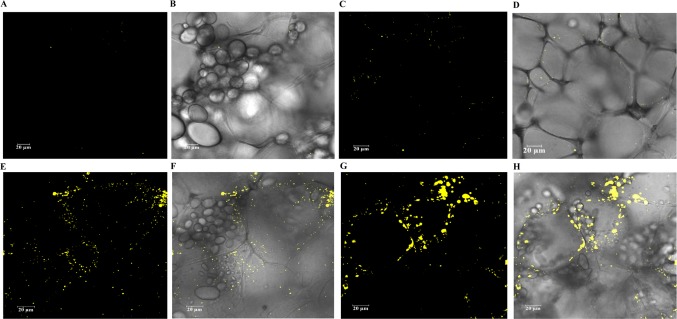
Confocal scanning microscopy analysis of the LDs distribution in mature potato tubers. The LDs were stained with BODIPY (yellow), bright-field images of the unstained starch granules and cell wall structures formed the major background contrasted to the LDs. (A, B) Visualization of LDs in WT. (C, D) Visualization of LDs in WT-L5. (E, F) Visualization of LDs in HO69. (G, H) Visualization of LDs in 69-L3. The scale bars are located in the lower left corner for each photograph, sizes of the scale bars are all normalized to 20 µm.